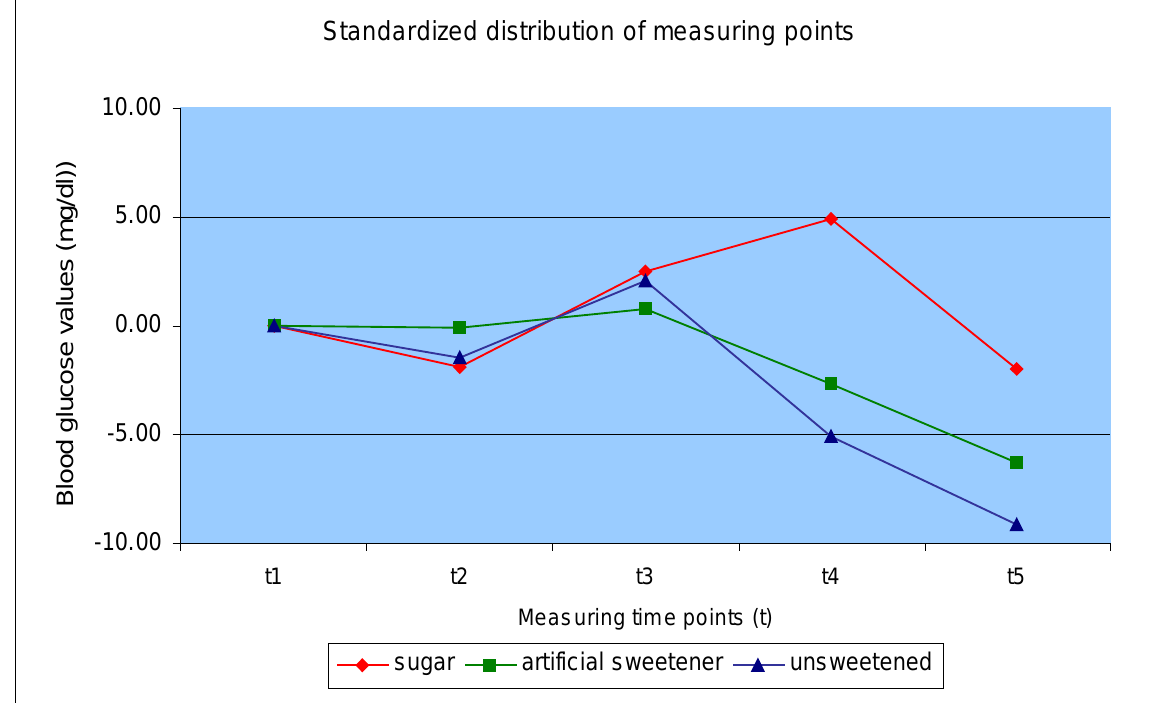
Figure 1. Standardized distribution of measuring